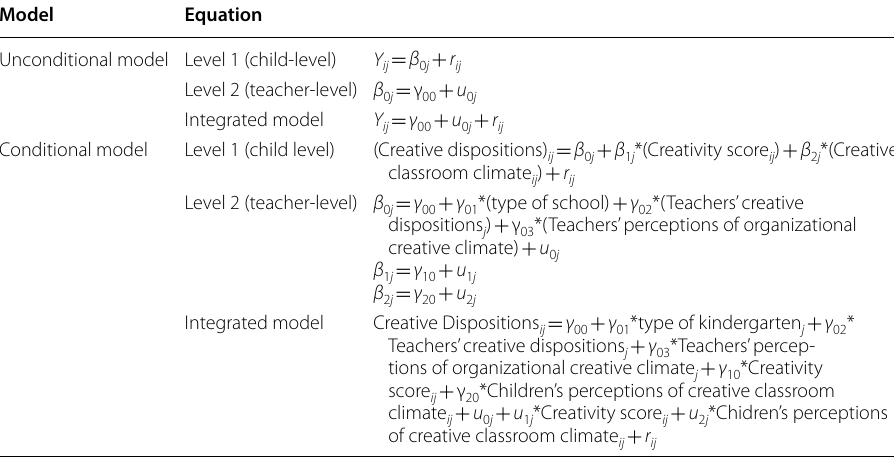
Table 2 Mathematical representation of the